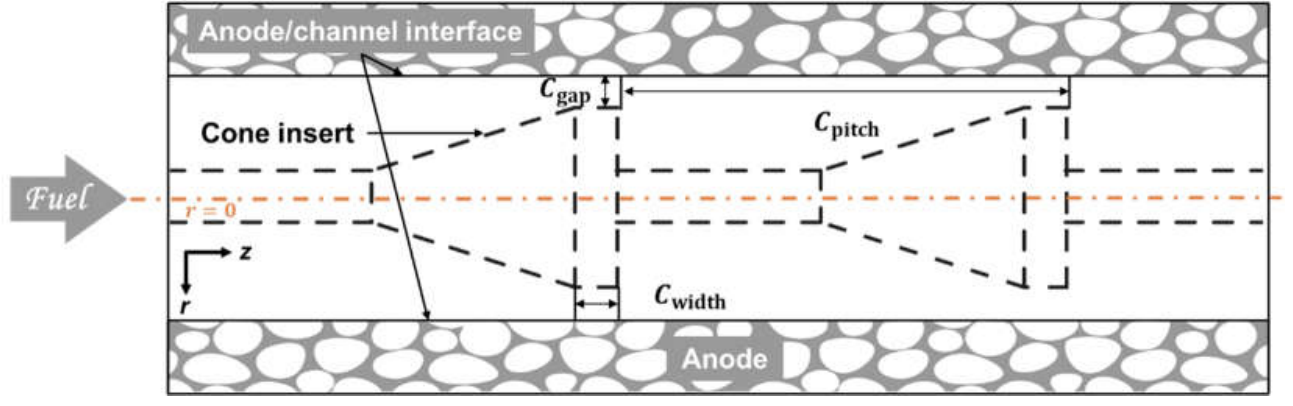
Figure 4. Schematic of the porous anode and cone-insert inside the fuel channel of micro-tubular SOFC.